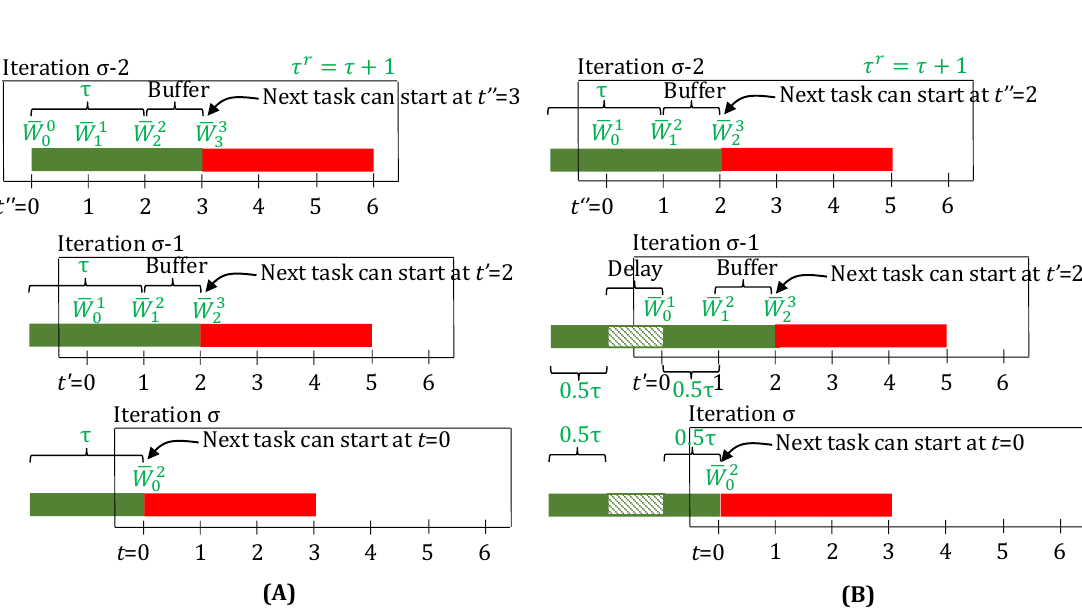
= τ + 1. ( A ) In iteration ij ij